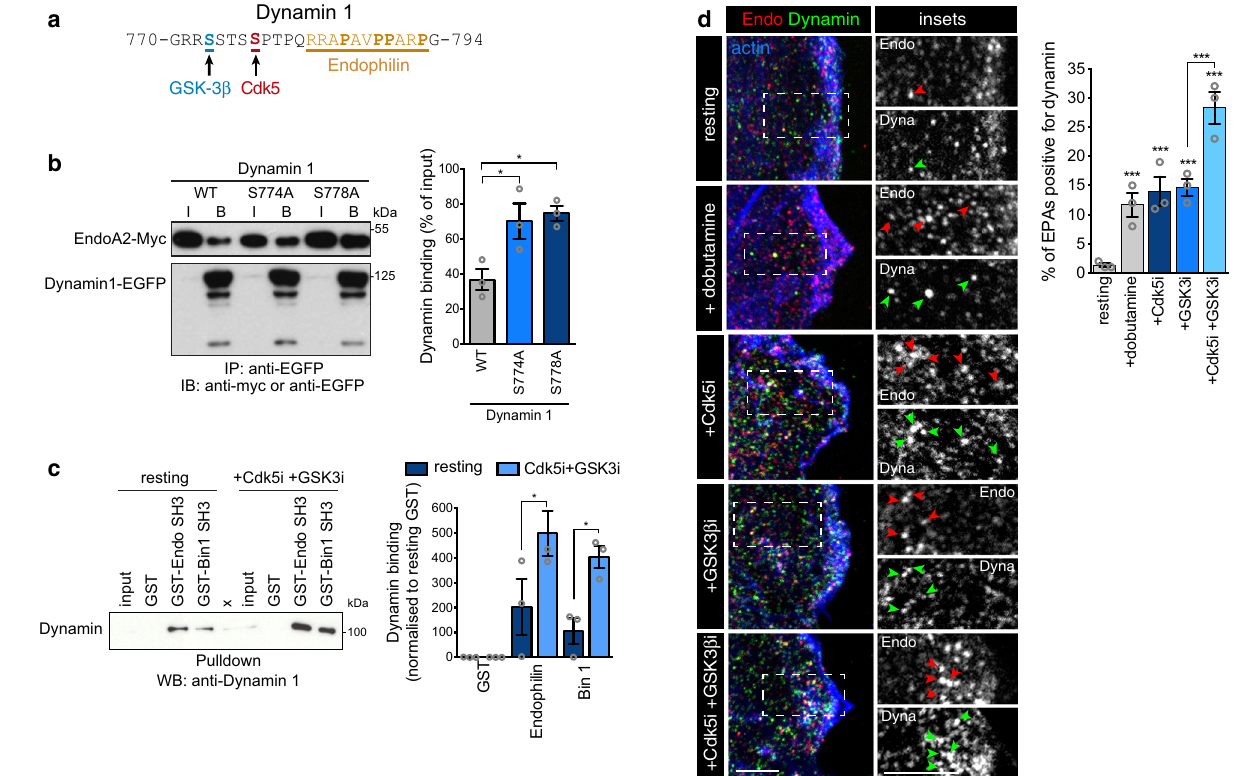
Fig. 4 Cdk5 and GSK3 β regulate Dynamin recruitment onto FEME carriers. a , Human Dynamin-1 sequence (aa 770-794). Amino acids phosphorylated by GSK3 β (S774) and by Cdk5 (S778) are shown in blue and red, respectively. The proline-rich motif to which Endophilin is known to bind to is shown in orange (underlined). b , Co-immunoprecipitation of Endophilin A2-Myc and Dynamin1-EGFP wild-type (WT), or non-phosphorylatable mutants S774A or S778A. Inputs (I) correspond to 0.5% of the cell extracts), and bound fractions (B) to 90% of material immunoprecipitated. Right, Histograms show the mean ± SEM from three independent biological experiments. Statistical analysis was performed by one-way ANOVA. * P < 0.05. c Pull-down experiments using beads with GST-SH3 domains of Endophilin A2 or Bin1, in resting cells or cells treated with 5 μ M Dinaciclib (Cdk5i) and CHIR-99021 (GSK3i) for 10 min. GST beads were used as negative control. X labels a lane that was not used in this study. Inputs correspond to 4% of cell extracts. Right, histograms show the mean ± SEM of Dynamin-1 binding, normalized to resting GST levels from three independent biological experiments. Statistical analysis was performed by two-way ANOVA. * P < 0.05. d Recruitment of endogenous Dynamin onto FEME carriers in RPE1 cells treated for 10 min with 5 μ M Dinaciclib (Cdk5i) and/or CHIR-99021 (GSK3i) or not, followed by 10 μ M dobutamine for 4 min. Arrowheads point at FEME carriers. Scale bars, 5 μ m. Histograms show the mean ± SEM from three independent biological experiments ( n = 50 cells per condition). Statistical analysis was performed by one-way ANOVA. *** P <